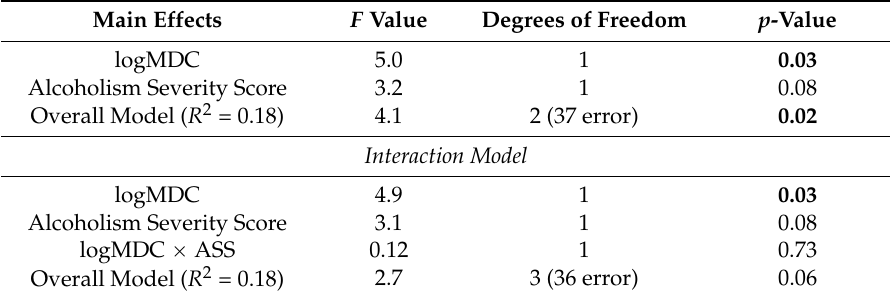
Table 3. Linear Regression Model of logMDC (macrophage-derived chemokine) on SCL-90-R Phobia